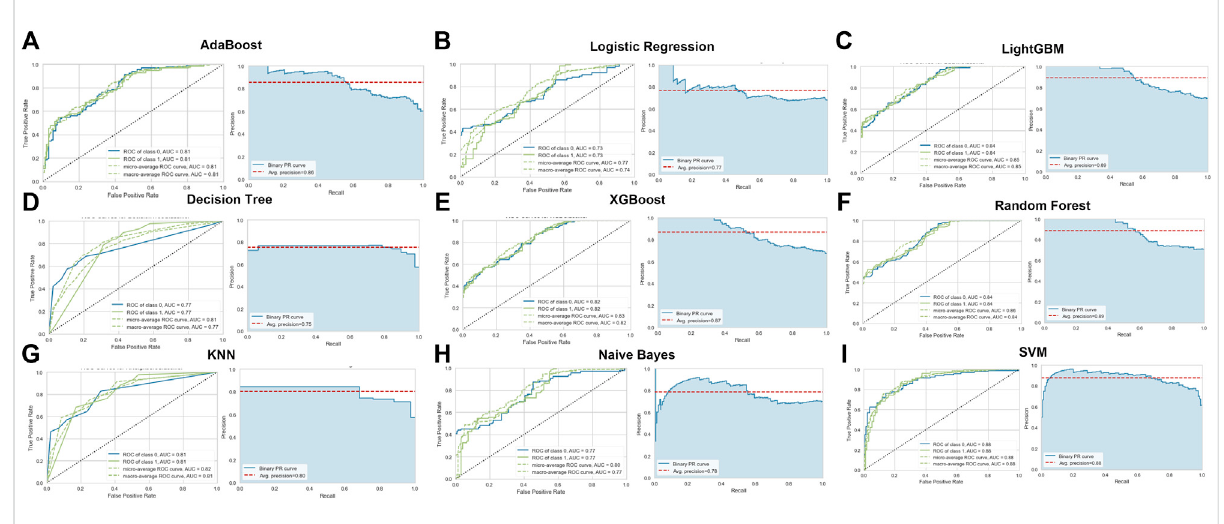
FIGURE 4 Evaluation ofthenine machine learning algorithmsbased ontheareaunder theROC curve(AUC) and PRcurve. (A)AdaBoostmachinelearning algorithm. (B) Logistic Regression machine learning algorithm. (C) LightGBM machine learning algorithm. (D) Decision Tree machine learning algorithm. (E) XGBoost machine learning algorithm. (F) Random Forest machine learning algorithm. (G) KNN machine learning algorithm. (H) Naïve Bayes machine learning algorithm. (I) SVM machine learning